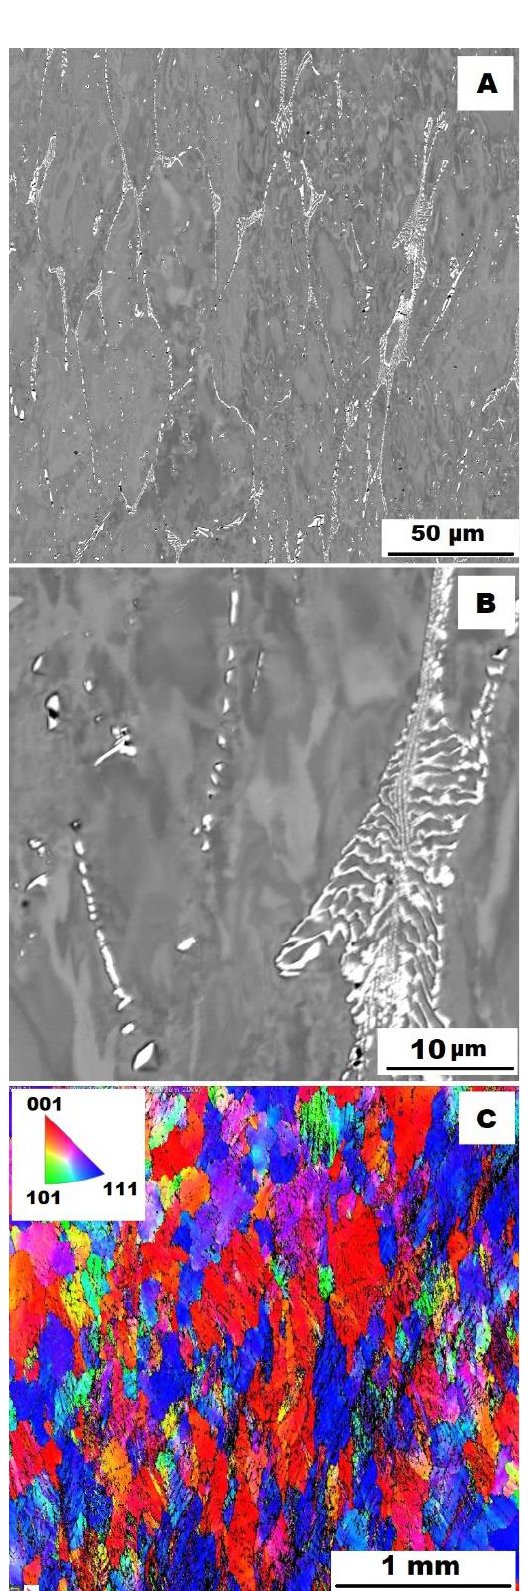
Figure 14. The structure of Fe–28Al–5Si–2Mo–1B alloy in the as-cast state after compression test at 600 °C. ( A ) Overview of the structure-10 kV, BSE. ( B ) Detail of the structure-10 kV, BSE. ( C ) EBSD map of grains-area 3 × 3 mm, step size 2 µm, 20 kV.